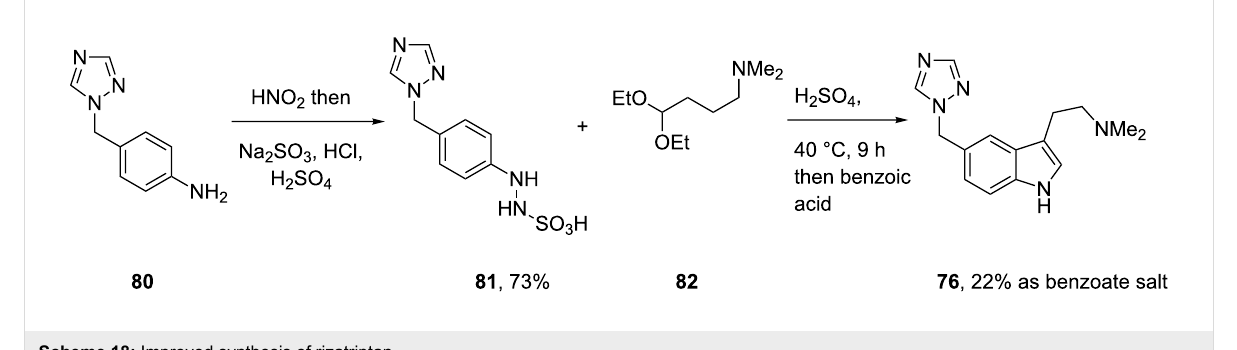
Scheme 18: Improved synthesis of